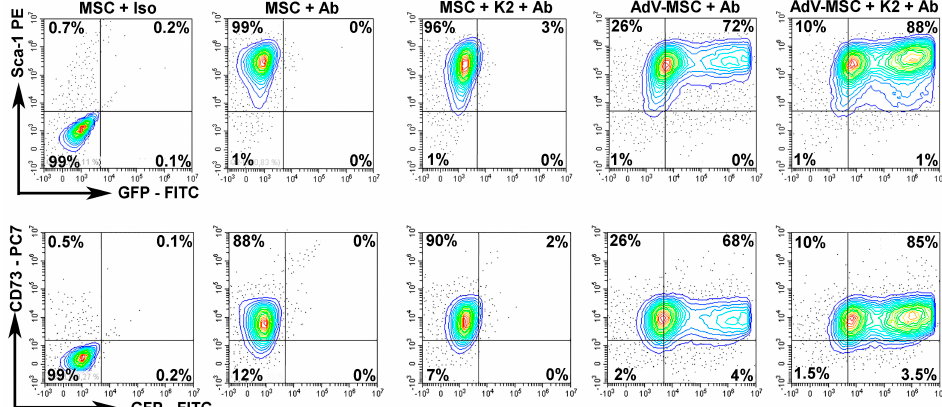
Figure 6. K2TS does not alter the markers expressed by MSC. The expression of Stem cells antigen-1 (Sca-1) and 5 ′ -nucleotidase (CD73) was tested in NOD-MSC by flow cytometry. MSC were incubated with the corresponding isotype antibody (MSC + Iso) to set the gates. MSC were incubated with the corresponding antibodies (MSC + Ab) or were treated with K2TS and incubated with the antibodies (MSC + K2 + Ab). In parallel, MSC were transduced with the adenovirus alone (AdV-MSC + Ab) or in the presence of K2TS (AdV-MSC + K2 + Ab). In the upper panel the specific antibodies were anti-Sca-1 and in the lower panel were anti-CD73 antibodies. Both transduced and untransduced cells expressed a high amount of the markers (~98%). The GFP expression was detected in 16–20% of the cells transduced with the adenovirus alone (AdV-MSC + Ab) and in 90 - 92% in cells transduced with the adenovirus together with the K2TS (AdV-MSC + K2 + Ab).